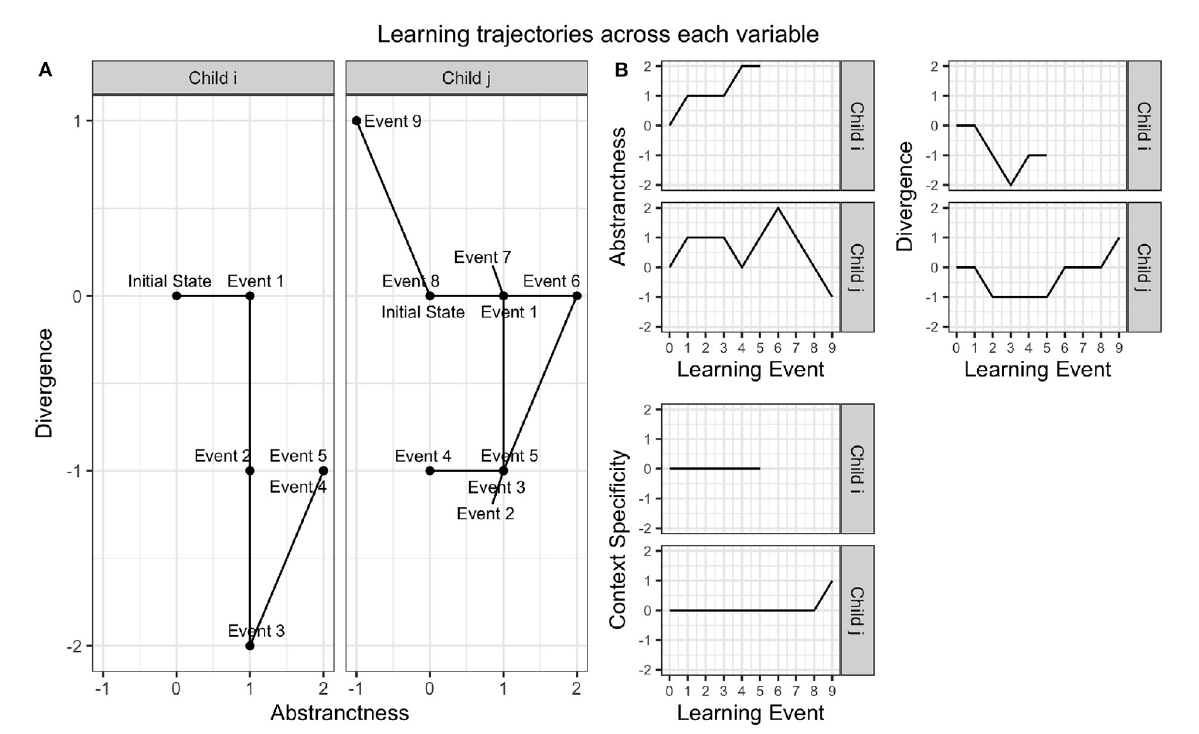
FIGURE3 Thought trajectories of child i ’s and child j ’s mental models of the Earth, as laid out in Tables 5, 6. (A) Shows the trajectory of each child with respect to Abstractness and Divergence. (B) Shows the trajectory for each child on each individual variable. We emphasize that this is not conceptual space; it is the space of possible modes of thought with respect to the dimensions abstractness, divergence, and context-specificity, i.e., the space of possible ways of traversing conceptual space. The geometrical relationships implied here are speculative and units were arbitrarily chosen for presentation.